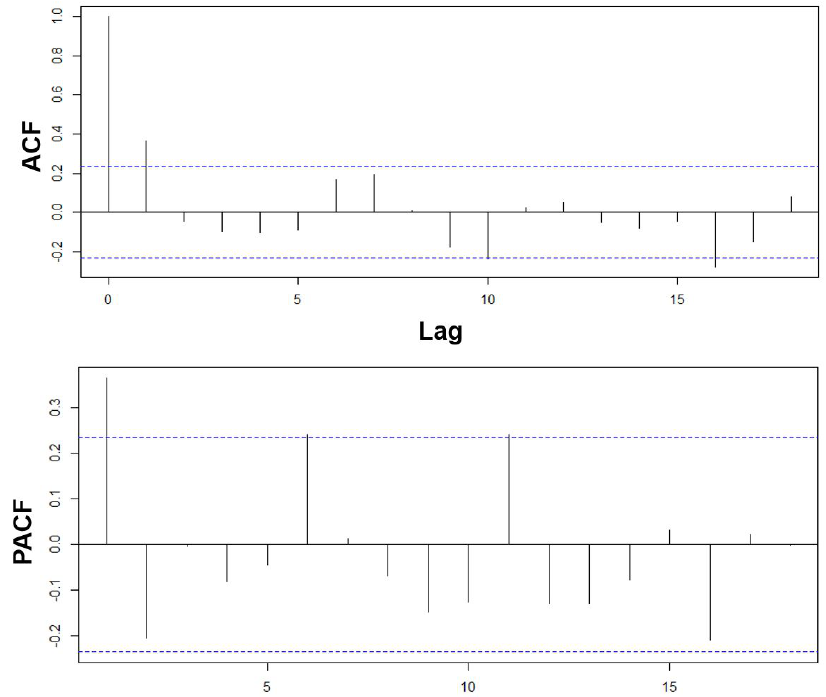
Figure 10. Lag analysis of the time series determines p th and q th elements depending on statistical significance. The model is AR(1)I(0)MA(1).